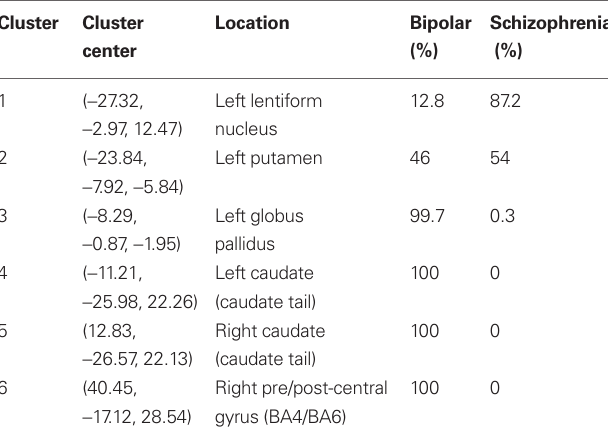
Table 3 | Percentage distribution of significant ALe clusters by disorder in enlarged gray matter